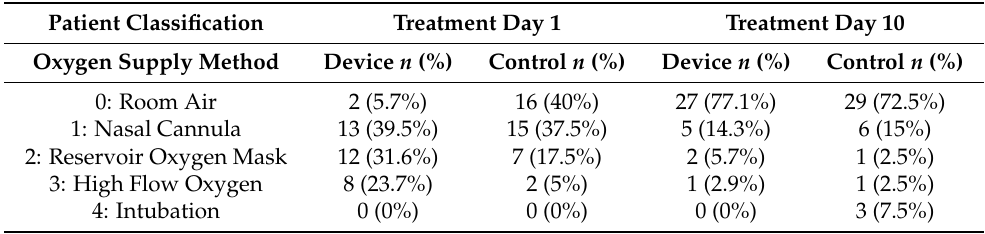
Table 6. Oxygen Therapy Method for Device Group and Control Group on the 1st and 10th Days of